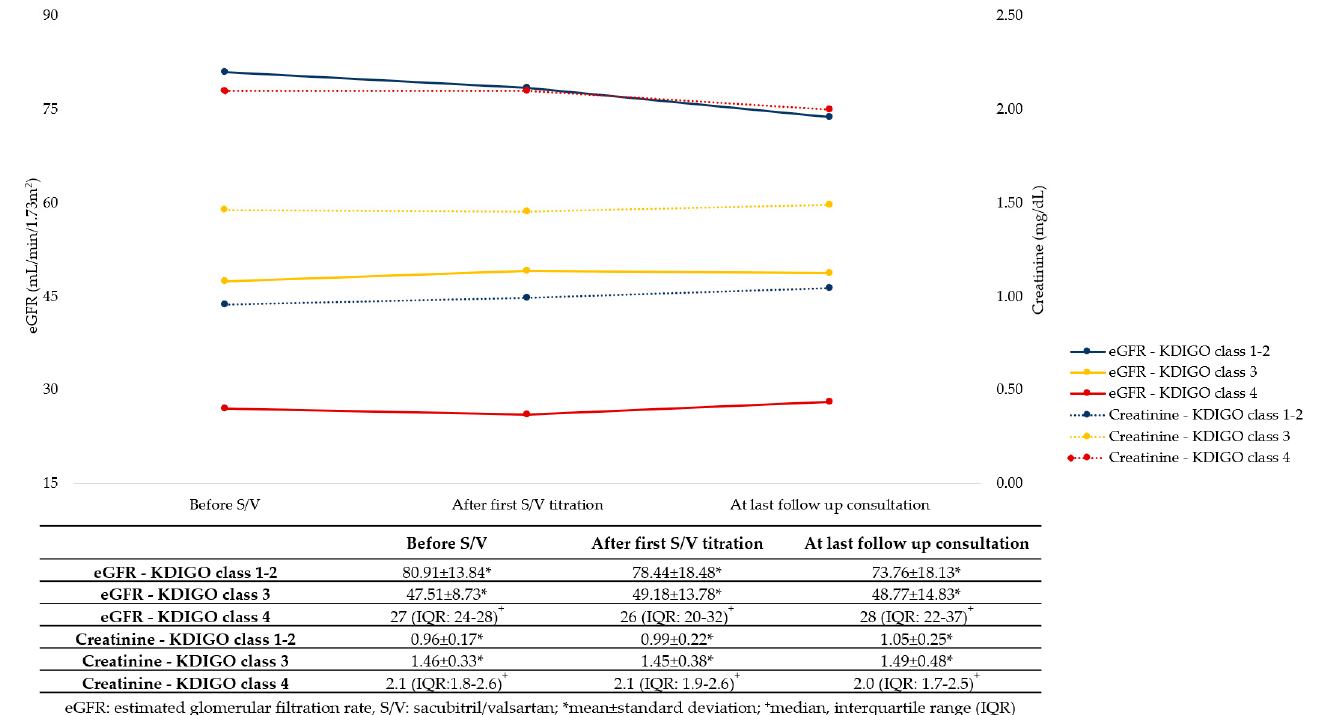
Figure 2. Creatinine and estimated glomerular filtration rate variation before, after first titration, and at last follow up consultation in patients that maintained sacubitril/valsartan at follow up.